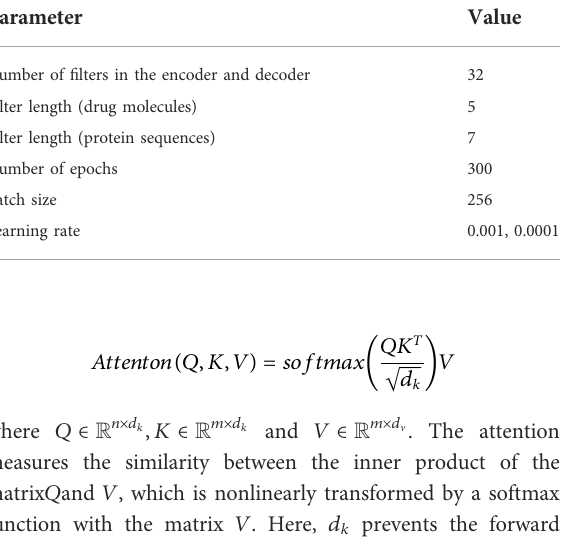
TABLE 1 Model parameters.